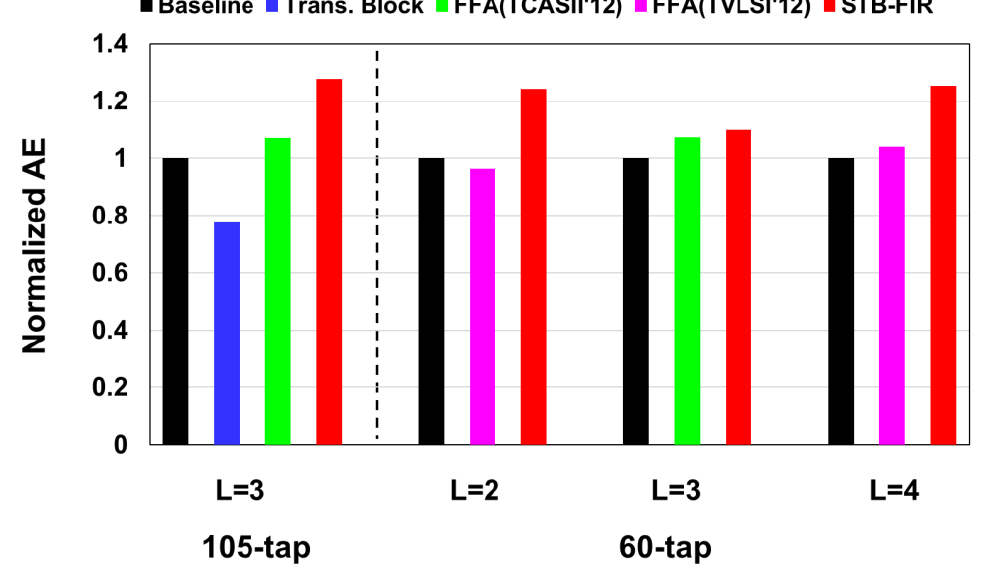
Figure 9. Normalized AE results of various fixed FIR implementations.